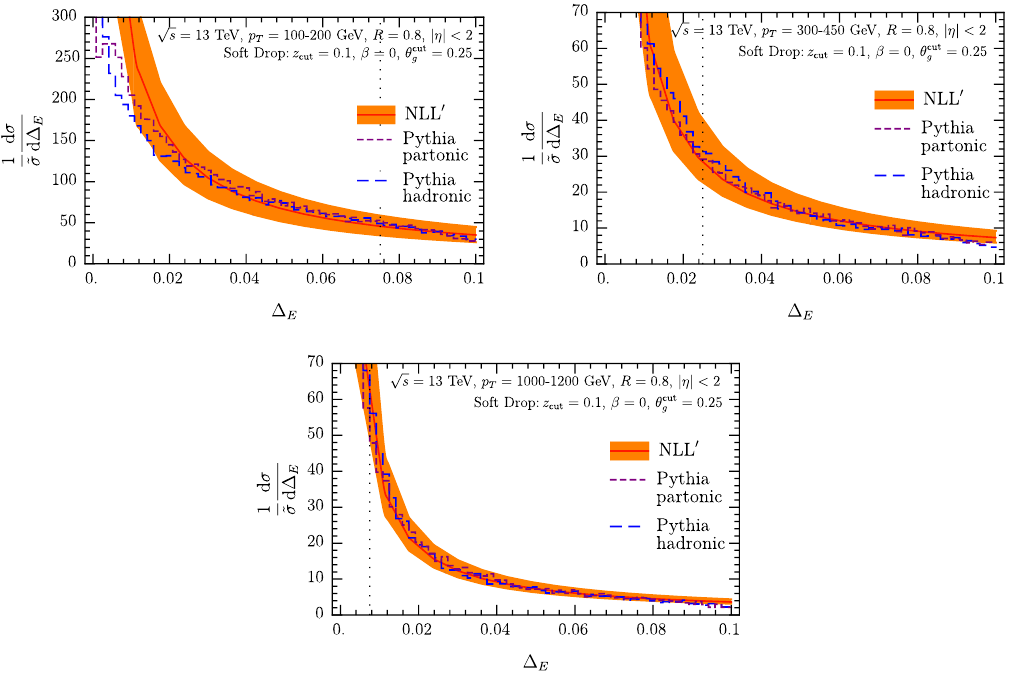
Figure 19 . Numerical results at NLL 0 (orange) for the jet energy drop with soft drop and z cut = 0 . 1 , β = 0 and θ cut = 0 . 25 . In addition, we show Pythia results at parton (purple dashed) and hadron g level (blue dashed) for comparison. The different panels correspond to different jet transverse momenta.